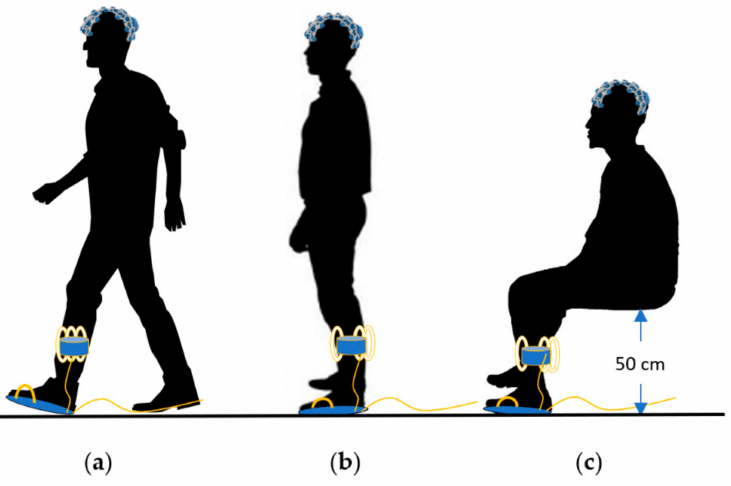
Figure 21. ( a ) Walking ( b ) standing ( c ) sitting postures of the participants while wearing equipment. The data obtained from the BCI and FBG were cleaned and preprocessed for the final stage of correlation. A machine learning model fitted the 3 FBG signals to selected BCI channels chosen by reading the literature and the results of previous experiments on channel classification. After reducing the number of BCI channels and preprocessing both the BCI and FBG data, a neural network model was used to predict the BCI channel waveform using the three FBG signals. Three models were considered in this project: Recurrent Neural Network (RNN), Long Short-term Memory (LSTM), and Gated Recurrent Unit (GRU). In Figure 22, the signal flow diagram for the machine learning process is